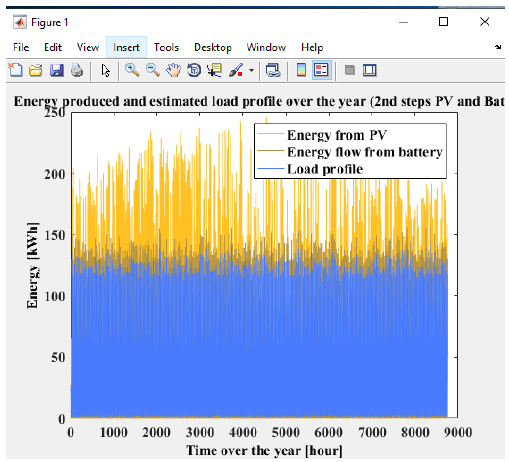
Figure 4. Energy Produced and estimated load profile over the year (Comparison of Time with